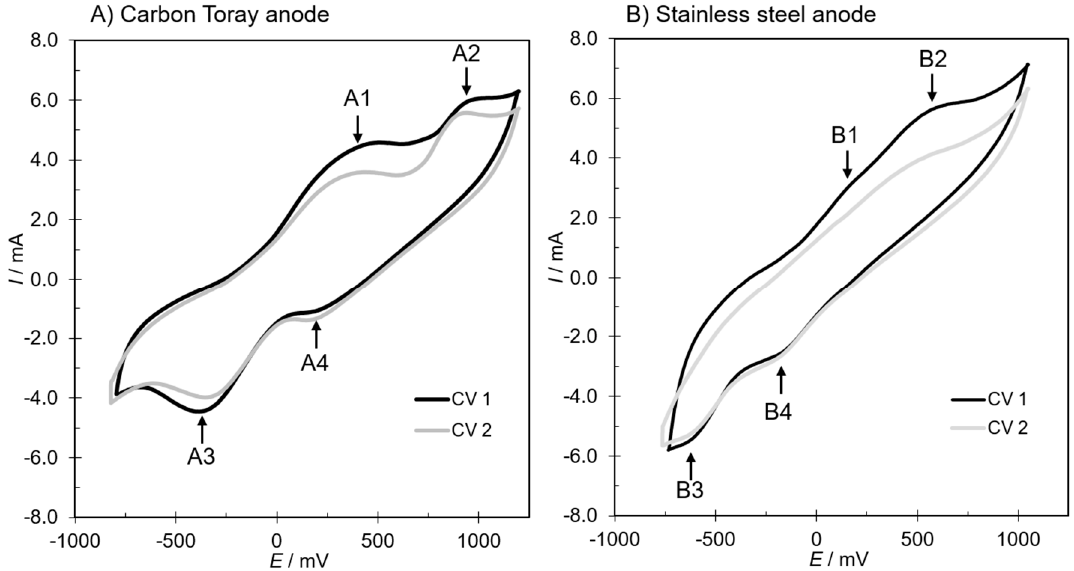
Figure 4. Cyclic voltammograms of carbon Toray ( A ) and stainless steel ( B ) in the SMFC recorded at 50 mV · s − 1 .